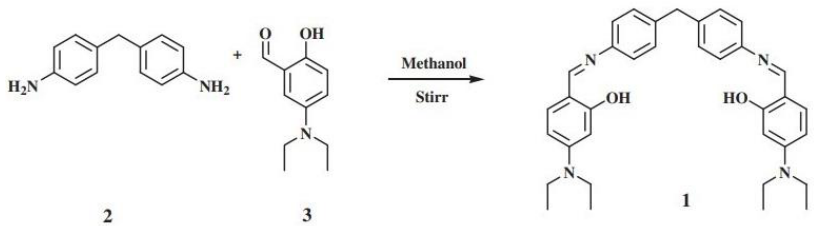
Figure 14. Structure diagram of multiple responsive fluorescent probes. Adapted with permission from K Kaur et al. [138]. 1: Zn 2+ complex 2: NH 2 ions 3: N ion and OH ion.